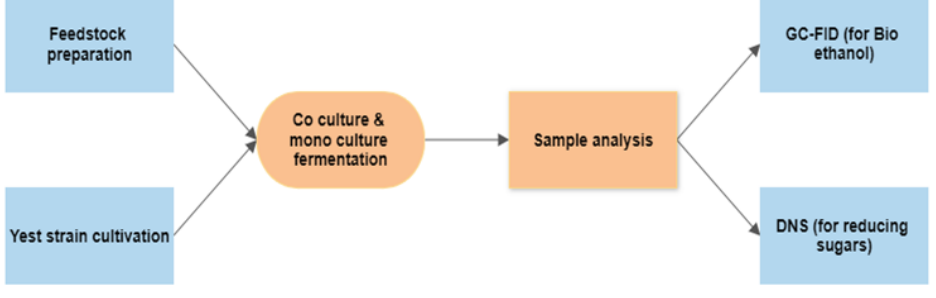
Figure 1. Overall methodology of the study.